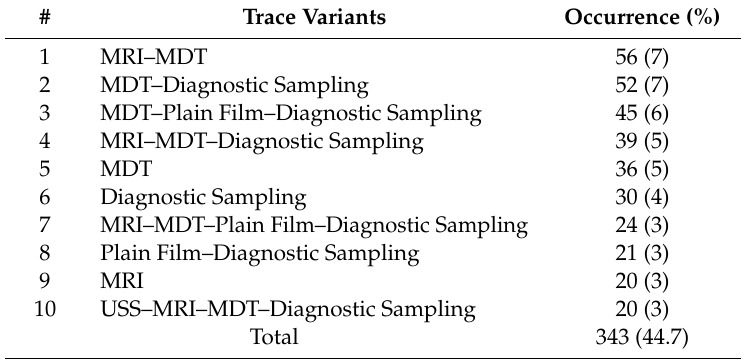
Table 6. Summary of the top ten trace variants based on the investigation